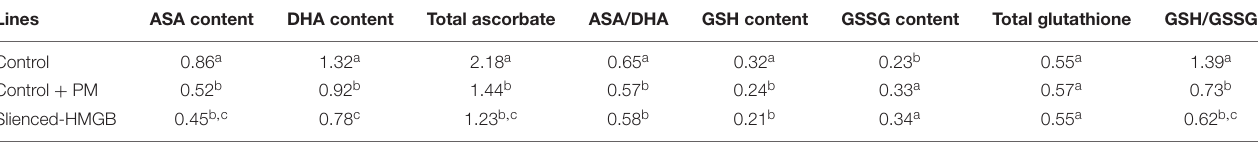
FIGURE 7 | Activity of key enzymes in AsA-GSH system in CsHMGB -silenced leaves of “D0351” plants. (A) DHAR activity. (B) MDHAR activity. (C) GST activity. (D) GR activity. Data are the means of three replicates with SEs, and different letters indicate a significant difference ( p < 0.05 by Tukey’s test). TABLE 1 | The ASA-GSH system in CsHMGB -silenced leaves from “D0351” genotype under propamocarb stress at 4